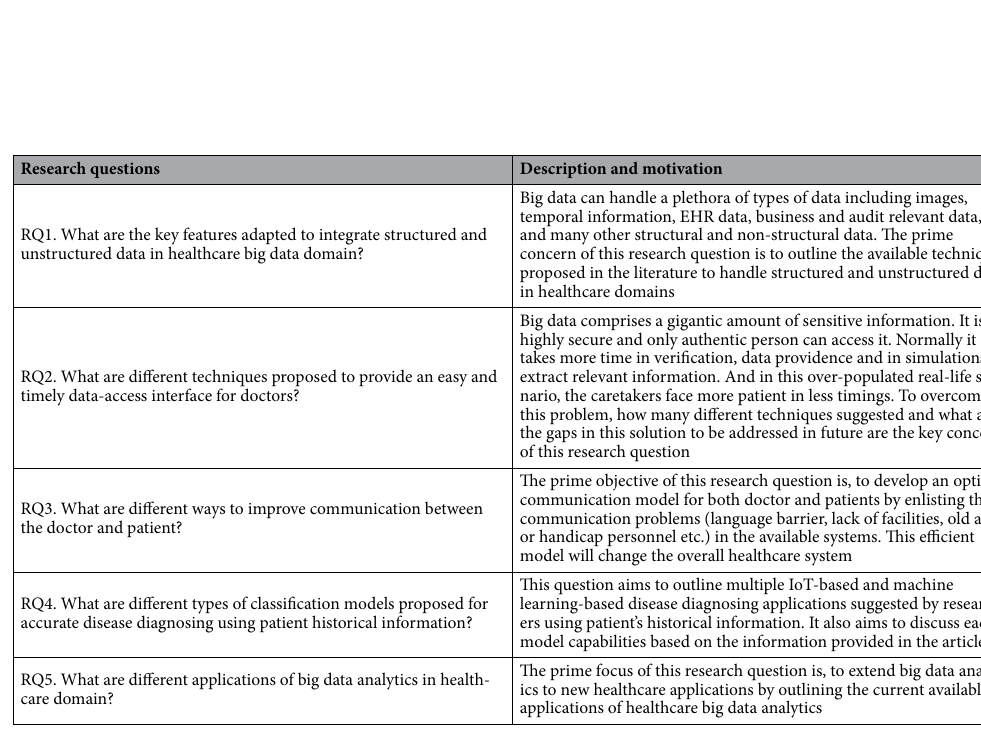
Table 1. Set of Research